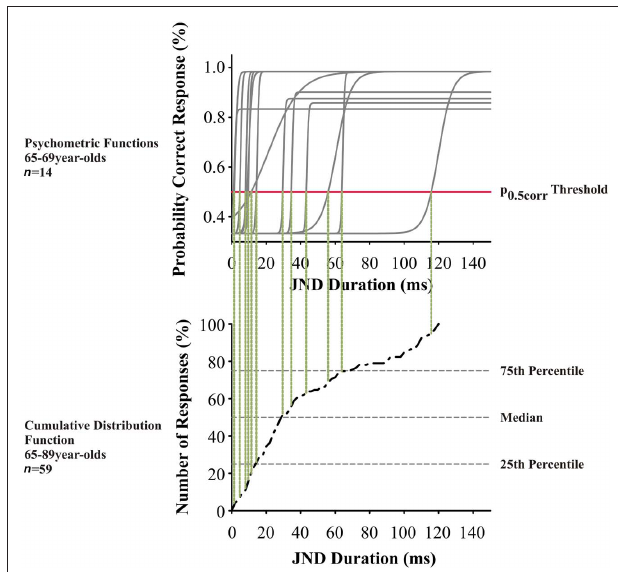
FIgure 2 | Top panel : Psychometric functions from the left ear of 65- to 69-year-old subjects ( n = 14) for interaural duration discrimination at 500 Hz. Each gray solid line indicates the psychometric function of one subject; the red horizontal line indicates the level of the p values. Lower 0.5corr panel : Cumulative distribution for interaural duration discrimination at 500 Hz in 65- to 89-year-old subjects. The p thresholds from left and right ears 0.5corr from all subjects ( n = 59) were included; the respective values of the above are indicated by vertical